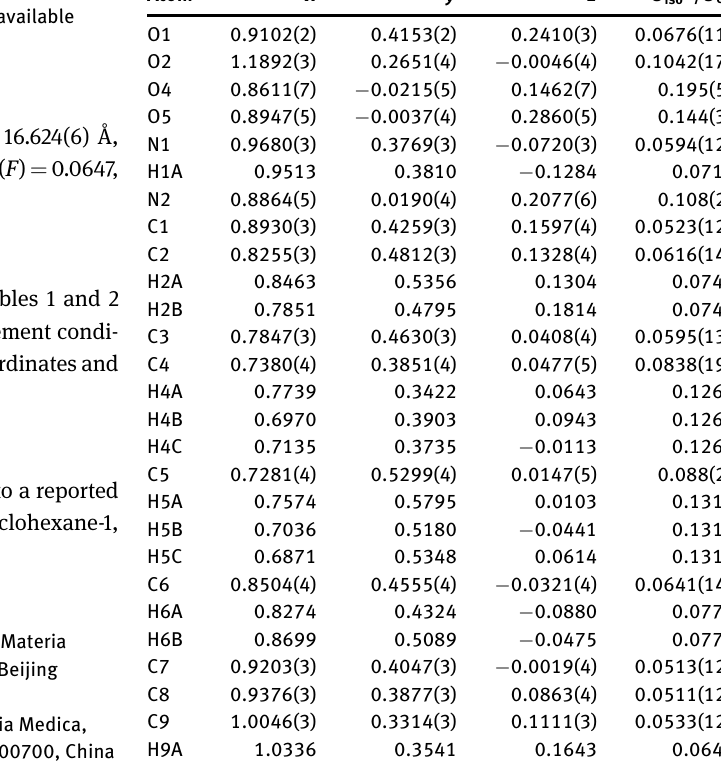
Table 2: Fractional atomic coordinates and isotropic or equivalent isotropic displacement parameters (Å 2